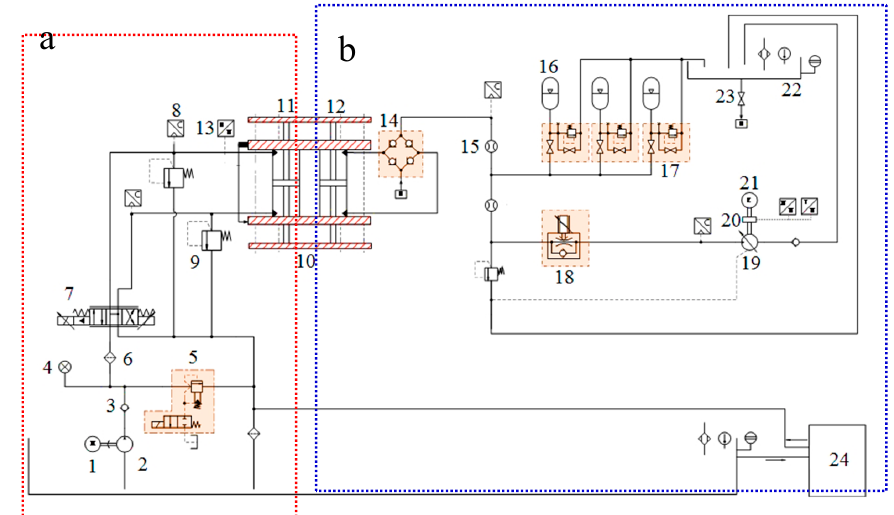
Figure 3. Schematic diagram of wave energy power experimental platform. ( a ) The float motion simulate system, ( b ) hydraulic transmission and electric power processing